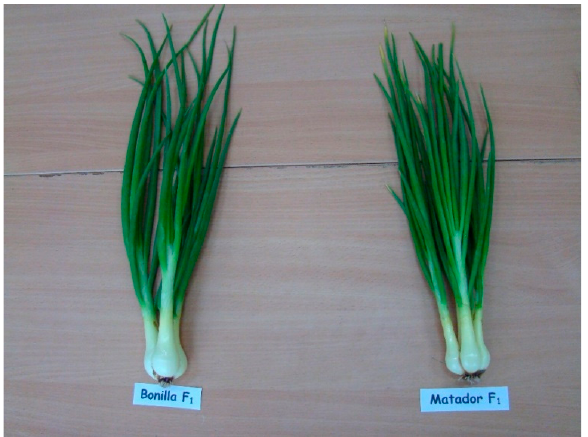
Figure 1. Shallots cvs. Bonilla F 1 and Matador F 1 grown for bunch harvest. Before the experiment had been established, chemical analyses of soil were per- (III) year of the formed by standard methods. N-NO 3 content was determined by the colorimetric method with the use of phenol disulfonic acid (UV–1201V spectrophotometer, Shimadzu Corpo- ration, Kyoto, Japan). The content of phosphorus (P) was determined by the colorimetric method (UV–1201V spectrophotometer, Shimadzu Corporation, Kyoto, Japan), calcium (Ca) and potassium (K)—by atomic emission spectrometry (AES) (Flame Photometers, BWB Technologies Ltd., Newbury, UK), and magnesium (Mg)—by atomic absorption spectrophotometry (AAS) (AAS1N, Carl Zeiss, Jena, Germany). Salinity was measured by the conductometric method (N5773 Conductivity Meter, Tel-Eko Projekt Ltd., Wroc ł aw, Poland), chloride (Cl) content and pH in H 2 O were determined by the potentiometric method. Due to minor differences in the obtained values, the results were presented as means for two years of the study (Table 1). Table 1. Chemical properties of soil. pH H 2 O Salt Concentration [g NaCl dm − 3 ]